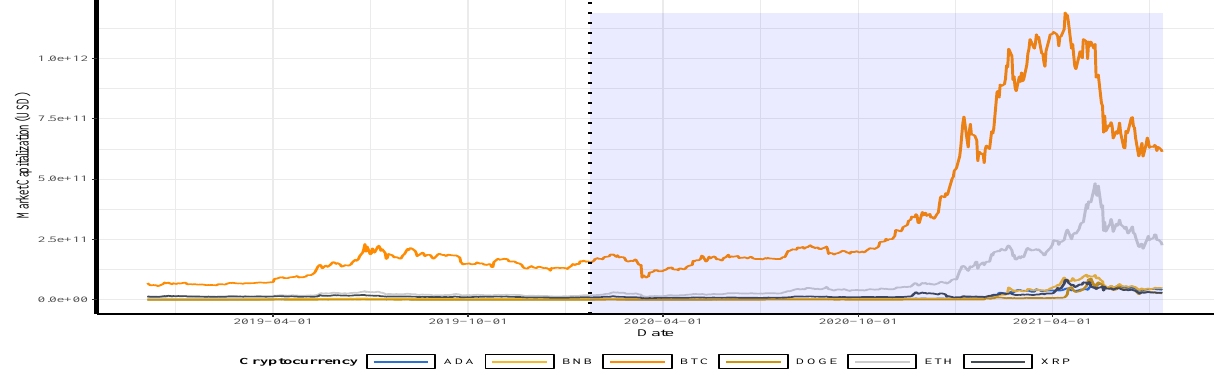
Figure 3. The market capitalization of the indicated cryptocurrencies. The vertical dotted line represents the threshold between the pre-COVID-19 period ( left ) and during the COVID-19 period ( right ) so that the shaded zone represents the period after the pandemic’s beginning to visualize its impact on the cryptocurrency